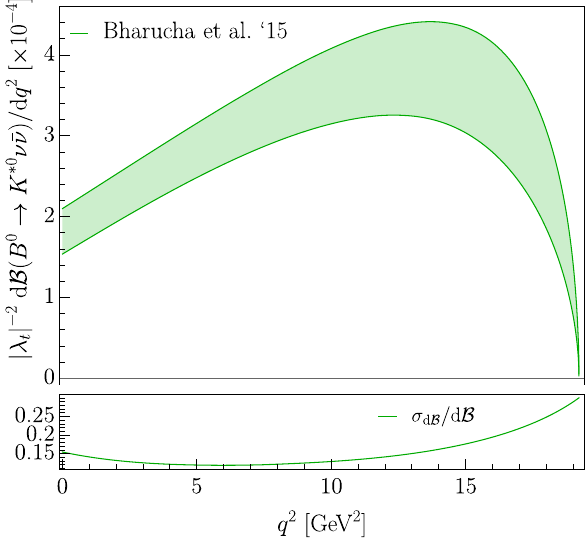
Fig. 3 Predictions for | λ t | − 2 d B ( B 0 → K ∗ 0 ν ¯ ν)/ d q 2 obtained by usingtheformfactorsfromRef.[42].Thelowerpanelshowstherelative uncertainty on this quantity as a function of q